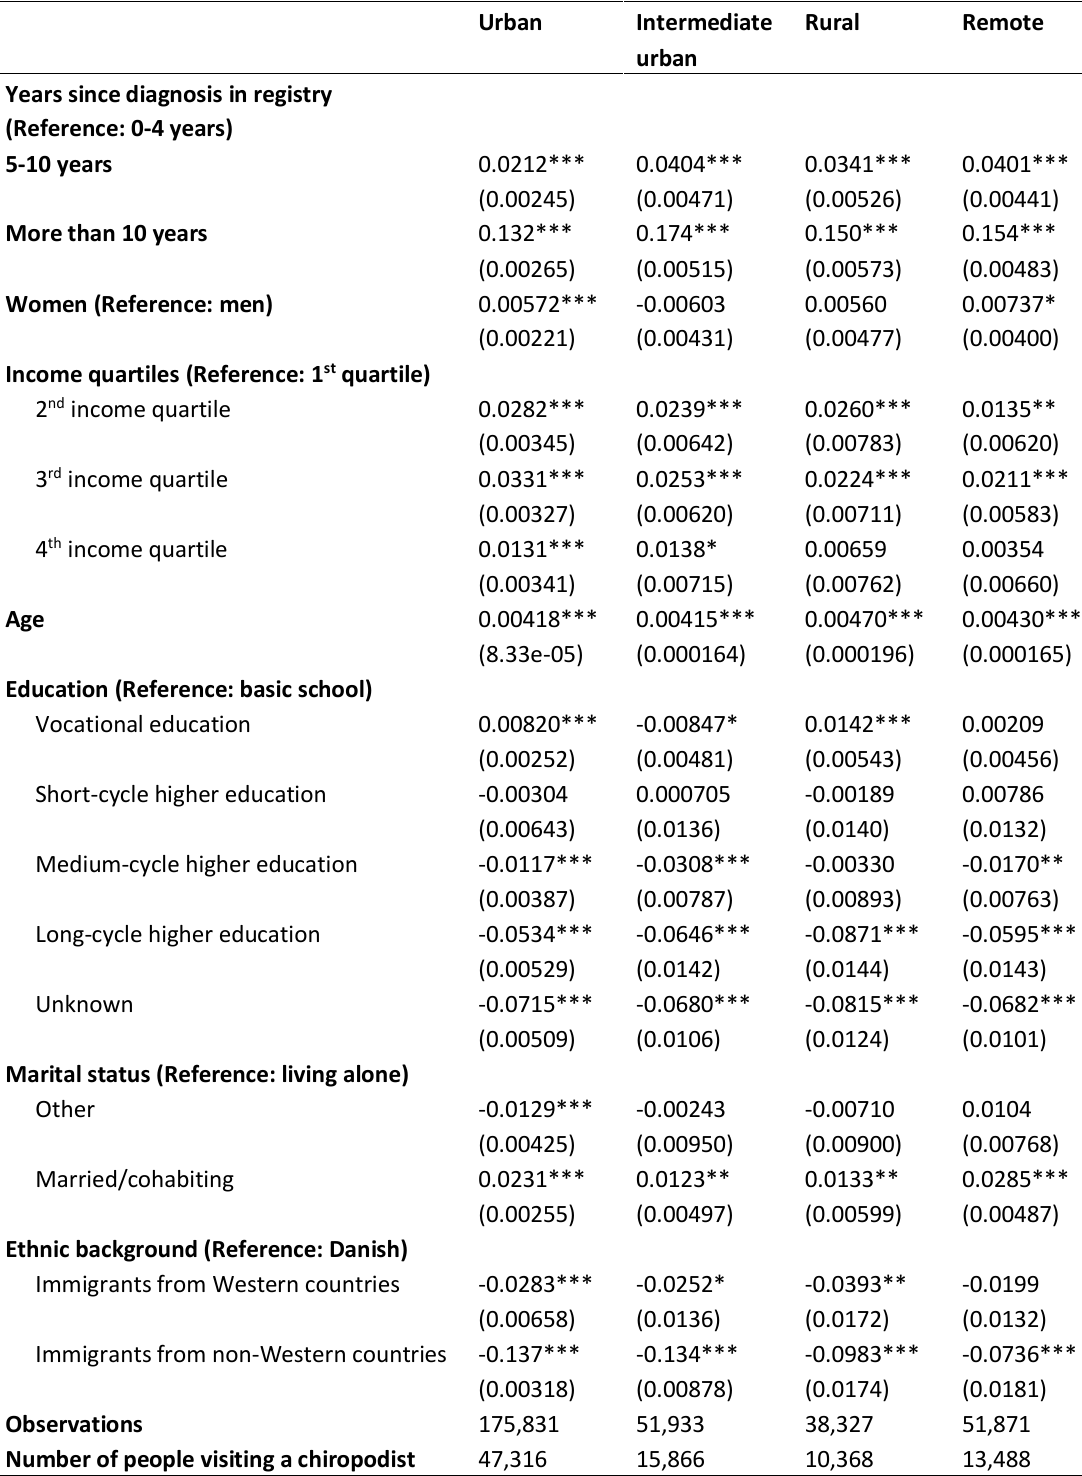
Table 5: Urban index conditional models, 2012, marginal effects